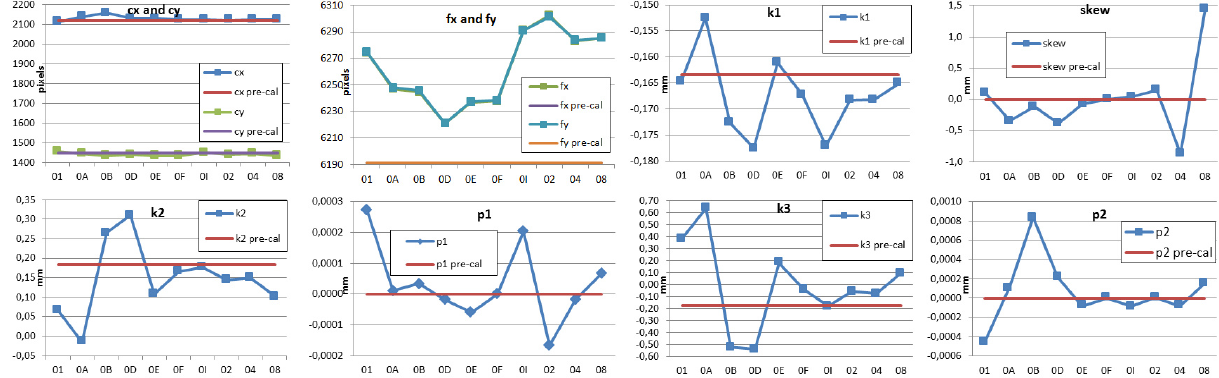
Table 13. Camera inner parameters computed by self-calibration in different sub-projects. Even if all photos have been taken with the same camera/lens settings, parameters significantly change respect to pre-calibrated values and in different